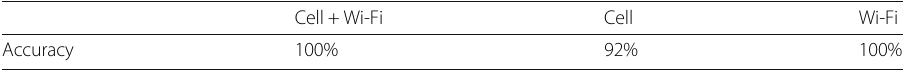
Table 2 The accuracy of level classification in the second-fold cross validation